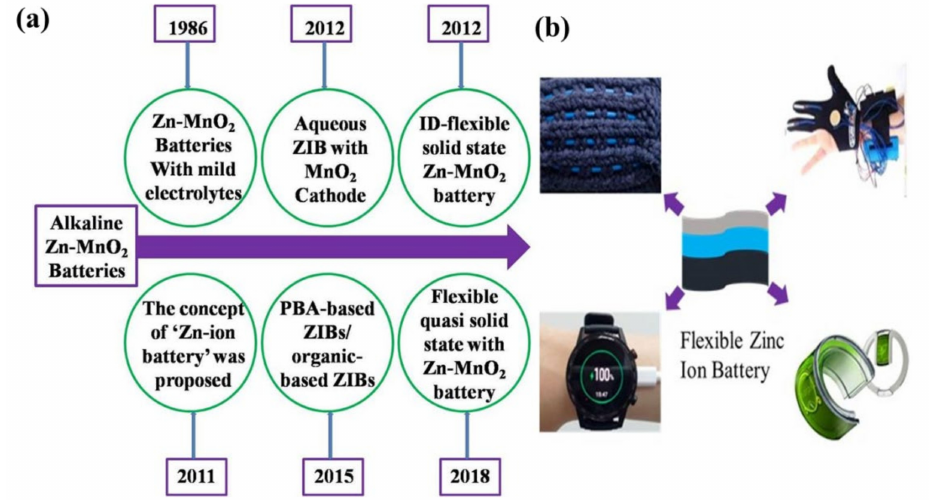
Figure 1. ( a ) A brief history of the development of ZIBs and FZIBs. ( b ) Exciting applications of flexible zinc-ion